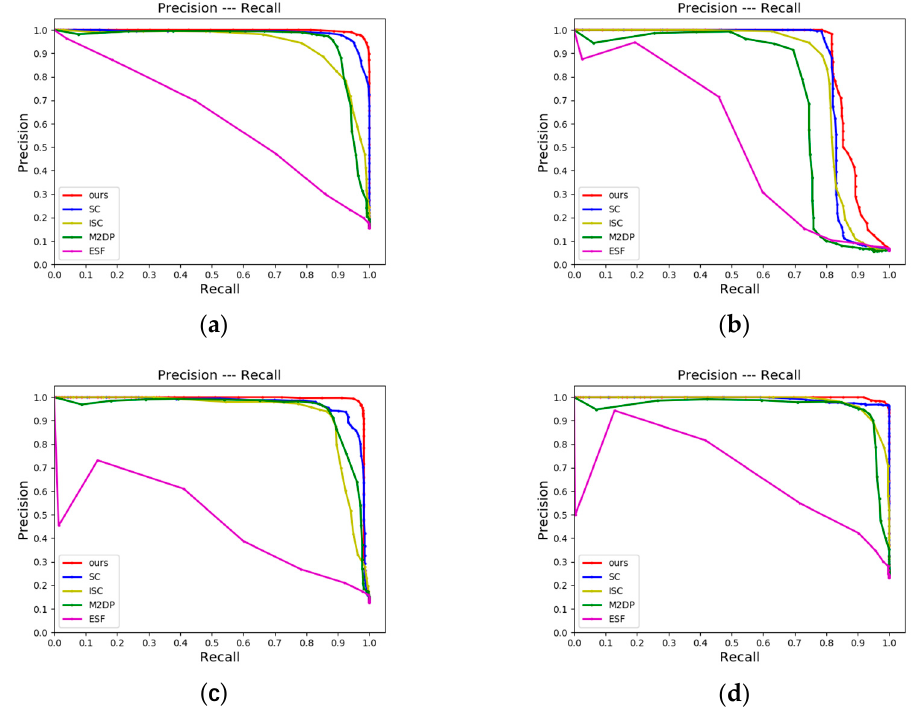
Figure 6. P-R curves corresponding to KITTI odometry sequences should be listed as the ( a ) P-R curve of KITTI-00; ( b ) P-R curve of KITTI-02; ( c ) P-R curve of KITTI-05; ( d ) P-R curve of KITTI-06.